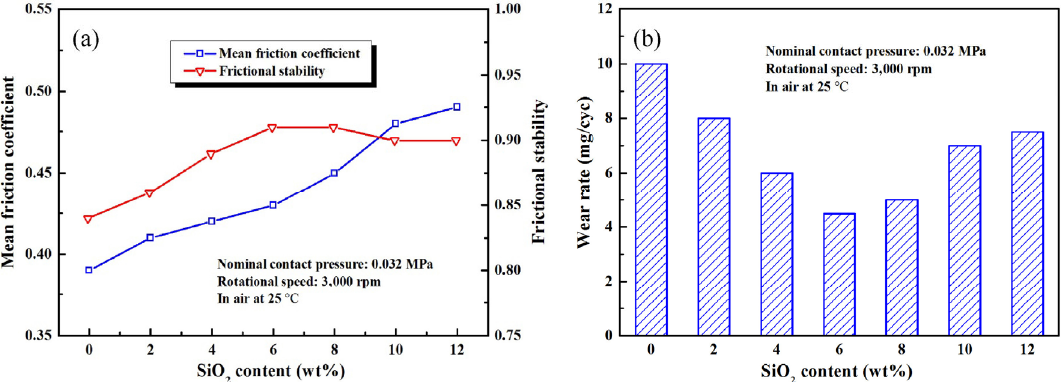
Fig. 4 Variations of (a) μ mean and FS, and (b) wear rate with SiO 2